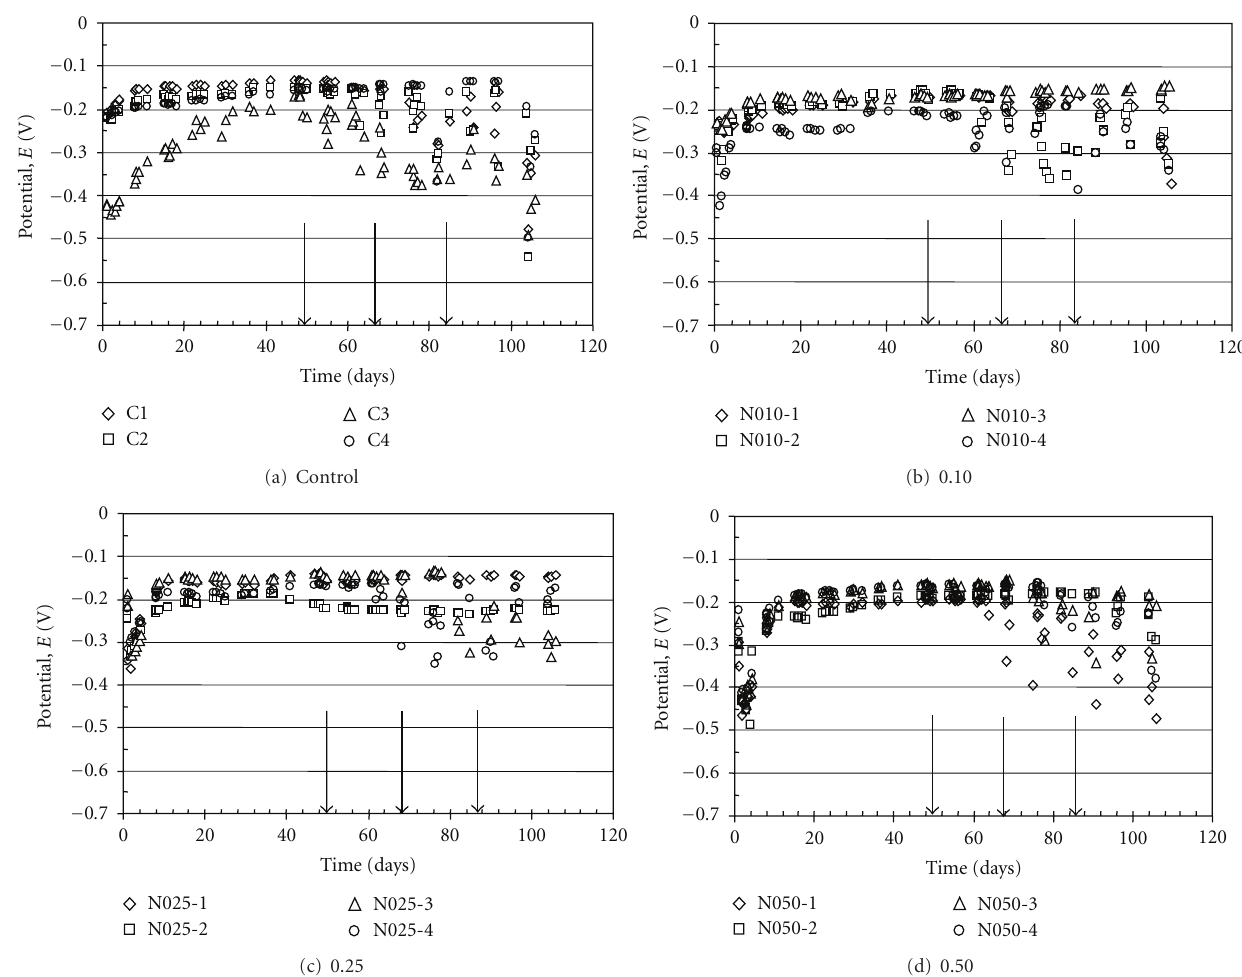
Figure 4: Half-cell potentials versus time of all SP solution electrochemical cells.